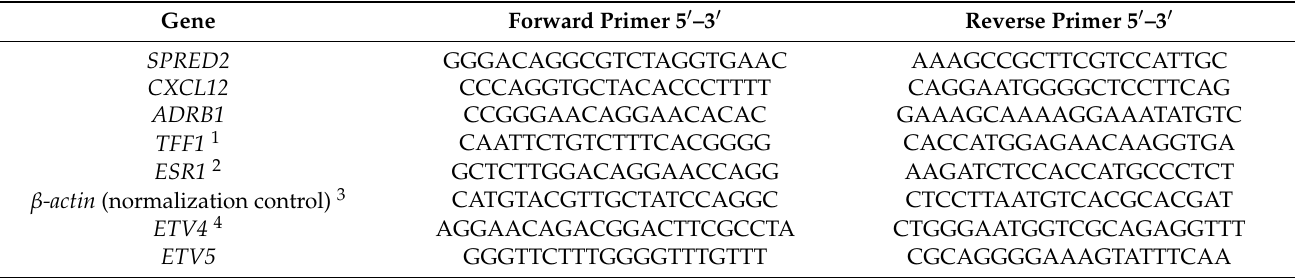
Table 3. Primer sequences used for RT-qPCR